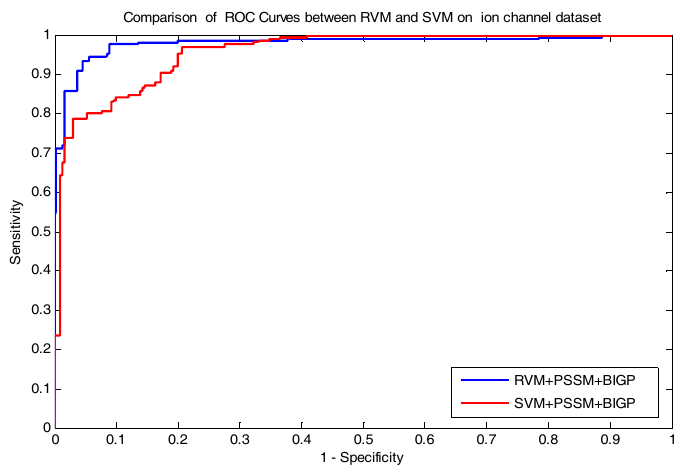
Figure 3. Comparison of ROC curves performed between RVM and SVM on an ion channel dataset.